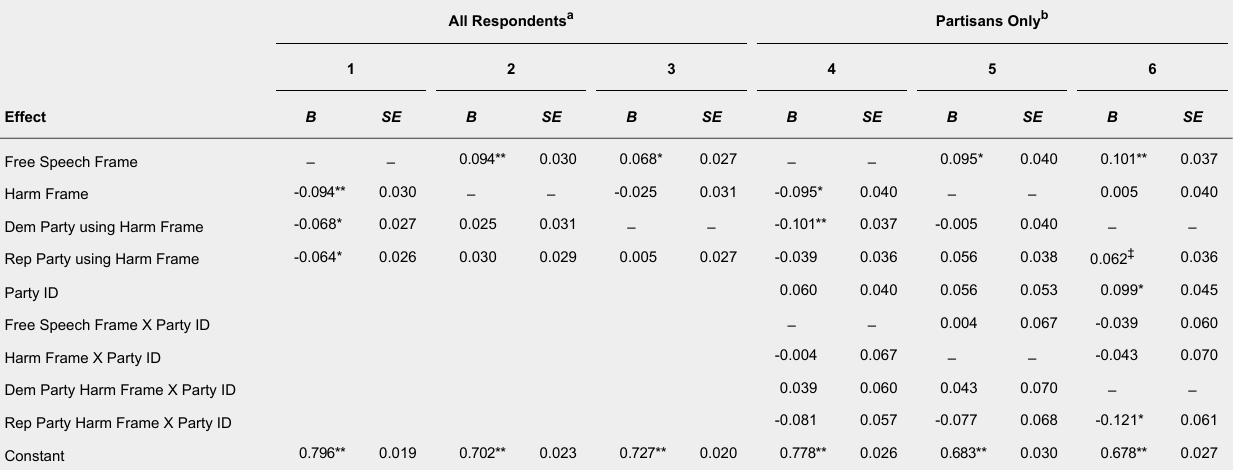
Experimental Treatment Effects for Anti-Muslim Speech (Study